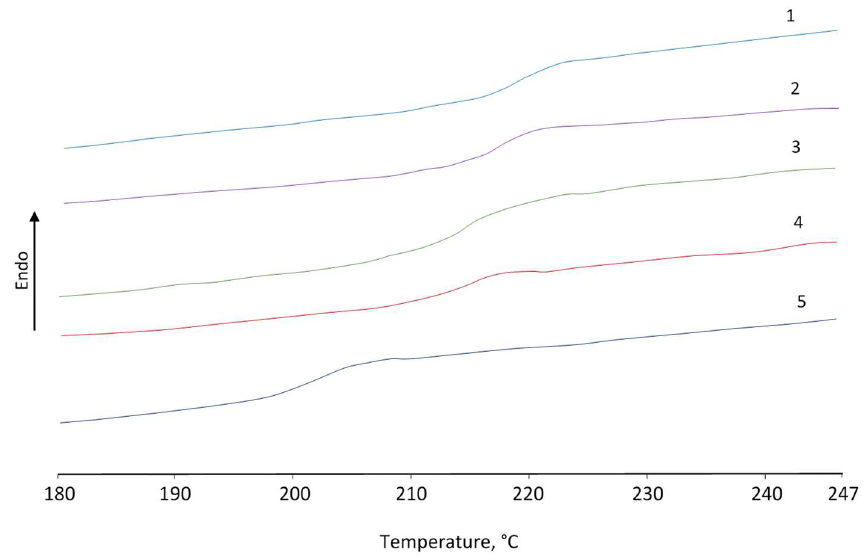
Figure 1. DSC curves of PPSU blends: 1—PPSU-17; 2—PPSU-6/38; 3—PPSU-2/54; 4—PPSU-3/292; 5—PPSU-3/n/f.